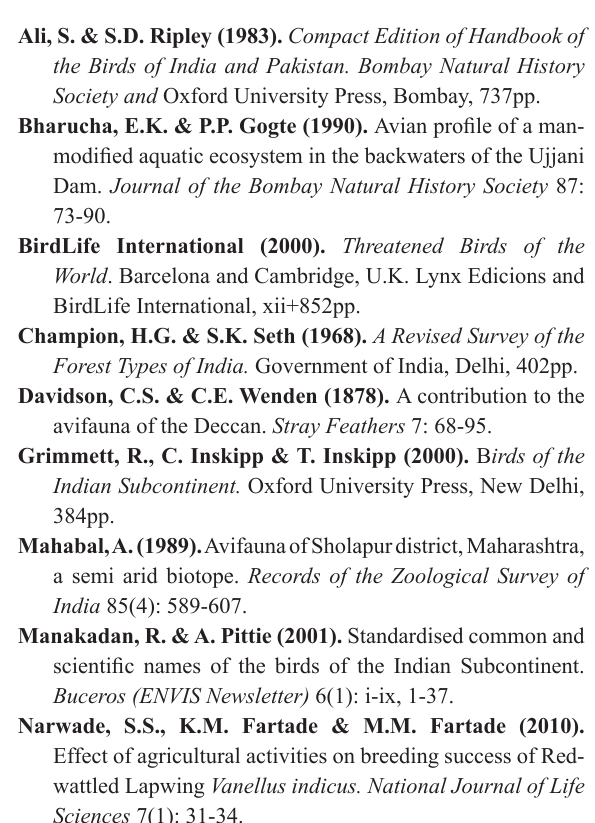
habitats A - Agriculture; G - Grassland; W - Wetland; NH - Near Human habitation; / - Sign indicates